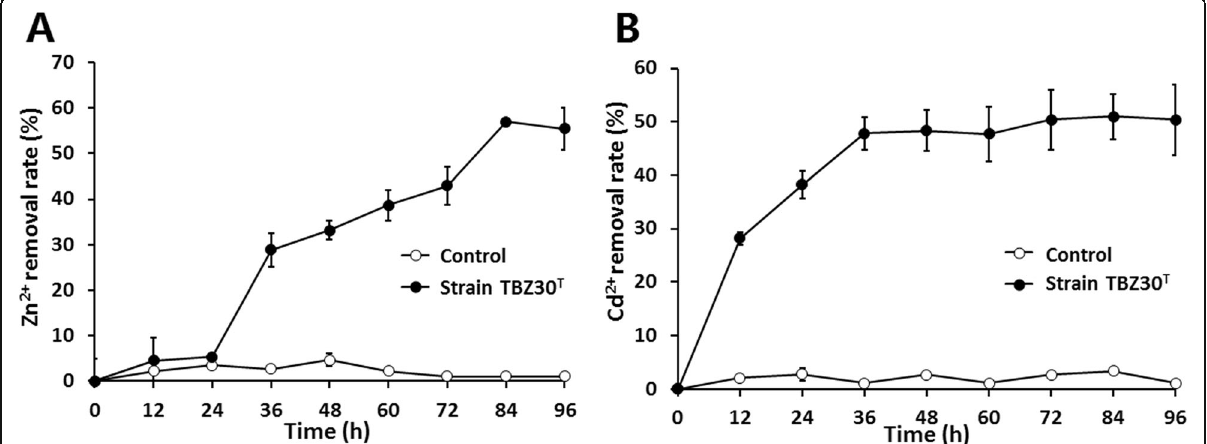
Fig. 4 Zn 2+ and Cd 2+ removal by strain TBZ30 T in R2A liquid media. a Zn 2+ removal by strain TBZ30 T ; ( b ) Cd 2+ removal by strain TBZ30 T . The control represents R2A liquid medium with 0.3 mM Zn 2+ or 0.25 mM Cd 2+ without the inoculation of strain TBZ30 T . Data are shown as the mean